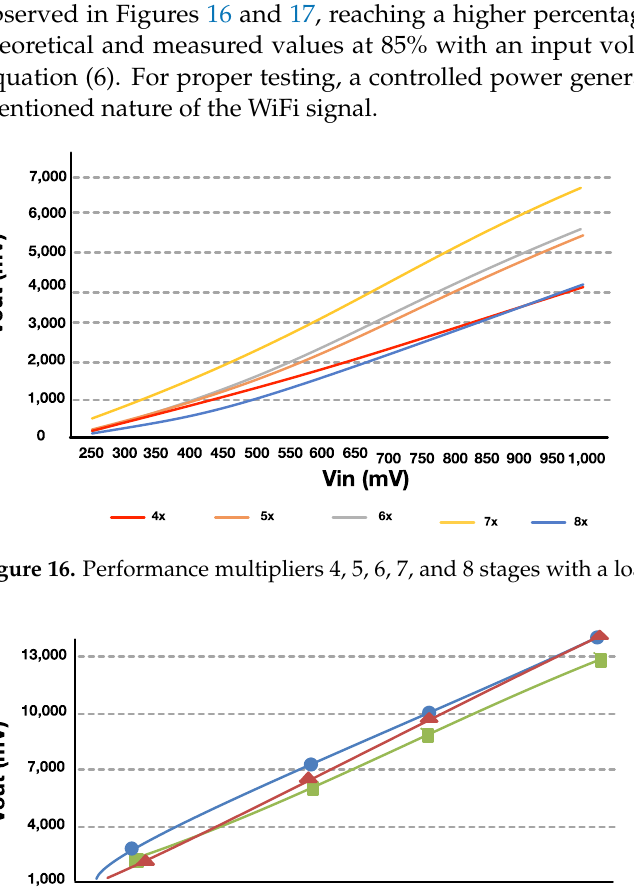
Figure 17. Theoretical, simulated, and measured open circuit voltage for 7 stages.